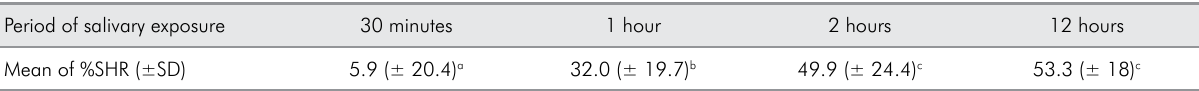
Groups whose means are followed by distinct letters differ significantly. (ANOVA/Tukey’s Test, p < 0.0001).